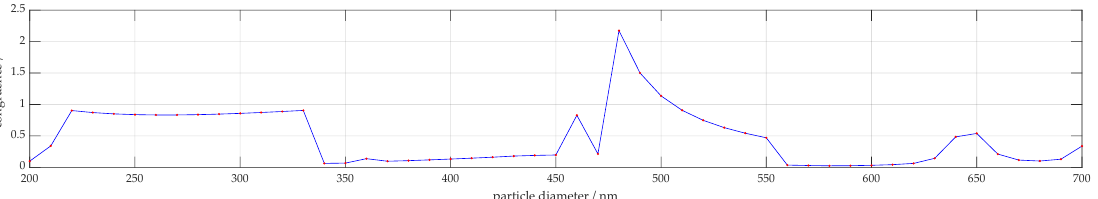
Figure 3. Classification of curves and division into intervals based on their gradient direction (( a ) data normalized; ( b ) data normalized and di ff erentiated) .